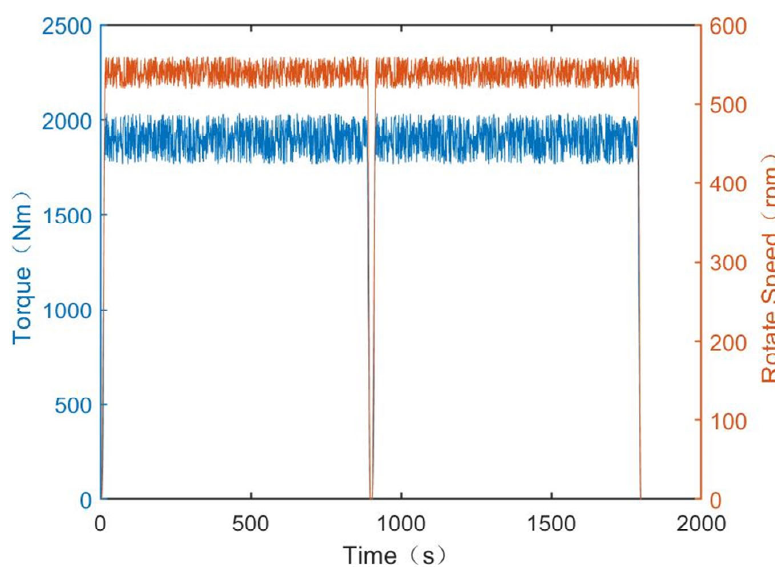
Figure 9. Torque and tachograph of the PTO.